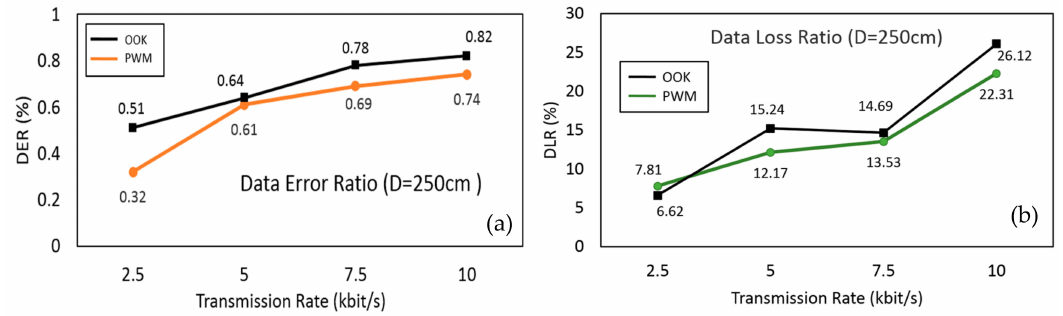
Figure 12. ( a ) DER and ( b ) DLR test at di ff erent transmission rate.